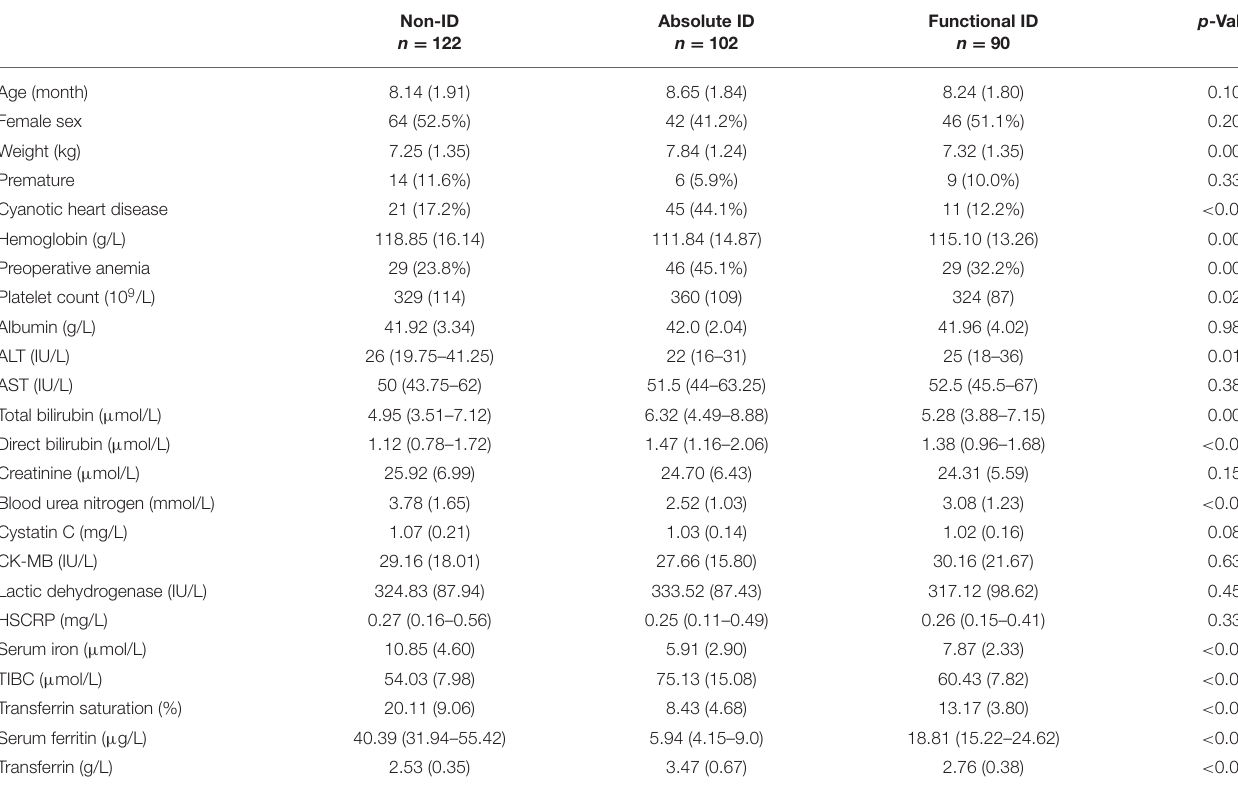
TABLE 1 | Baseline characteristics of the patient population.